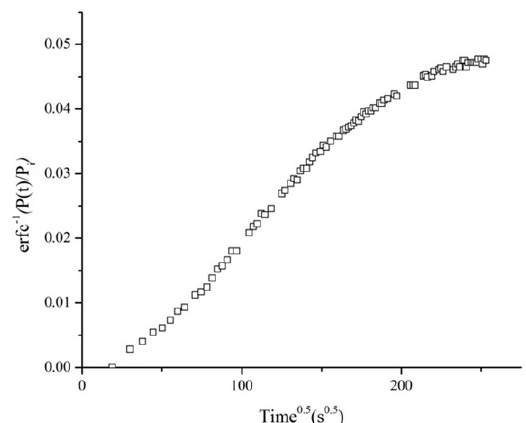
Figure 4. Pressure decay graphs at different temperature with equal initial pressure (6900 kPa).